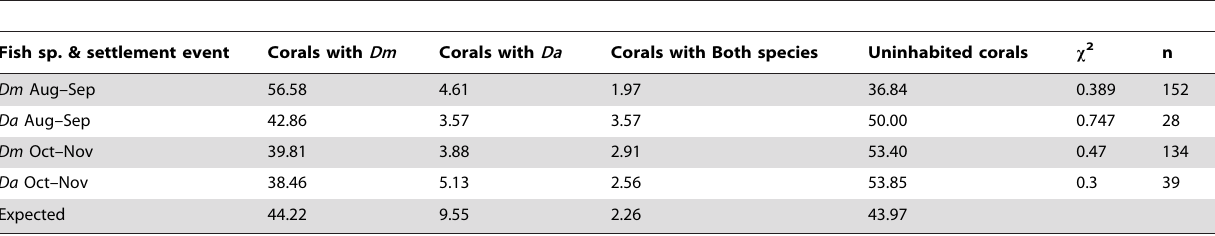
Table 3. Comparison of the percentage of selected corals from each coral category out of the entire selected corals, compared with the expected random percentage (i.e. the percentage of corals of each category out of all the tagged corals).